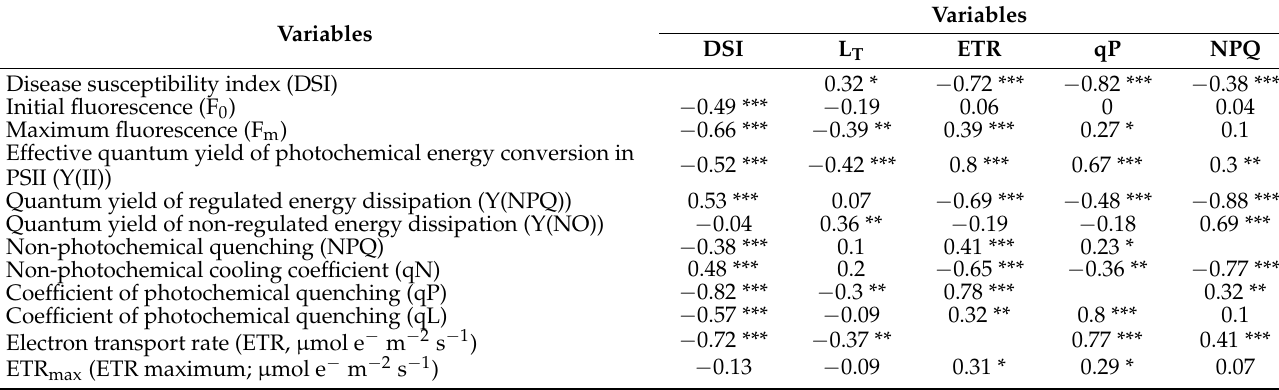
Table 2. Correlation coefficients (r) between the disease susceptibility index (DSI), leaf